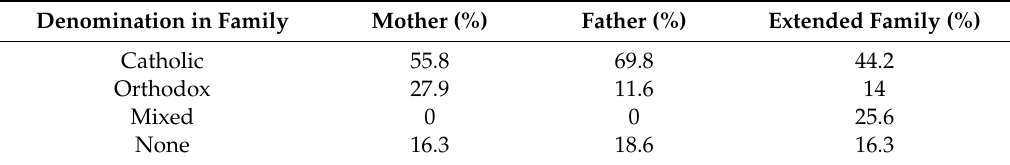
Table 4. People undeclaring their denomination vs. family.